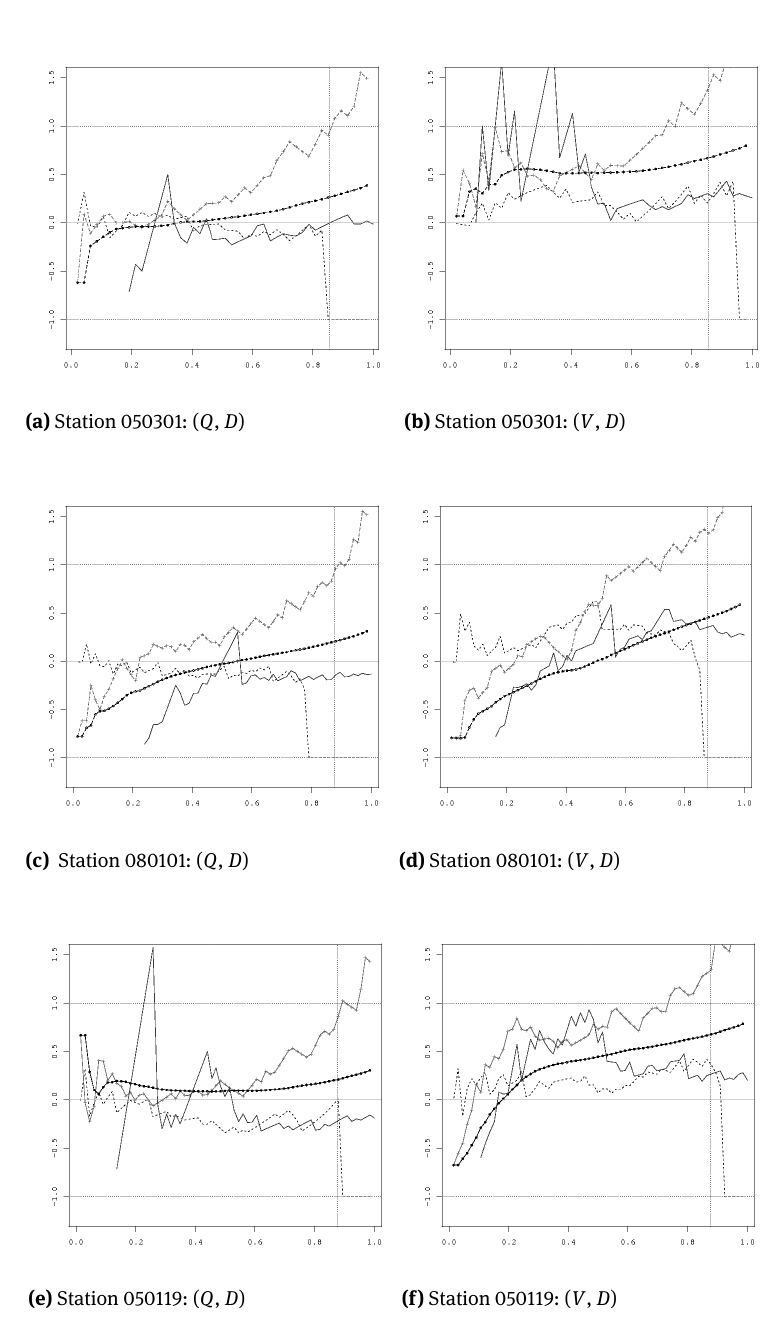
Figure 8: Estimators of the tail dependence function ¯ χ (.) of the pairs ( Q , D ) and ( V , D ) . The vertical axis corresponds to ˆ¯ χ ( u ) with ˆ¯ χ COLES (- - - -), ˆ¯ χ D (—), ˆ¯ χ H (-+-+-) and ˆ¯ χ Z (- ◦ - ◦ -), while the horizontal axis corresponds to threshold u = k / n with k = U , k U , k U , k 1, . . . , n − 1 . In horizontal dotted line, the upper and lower bounds on ¯ χ (.)